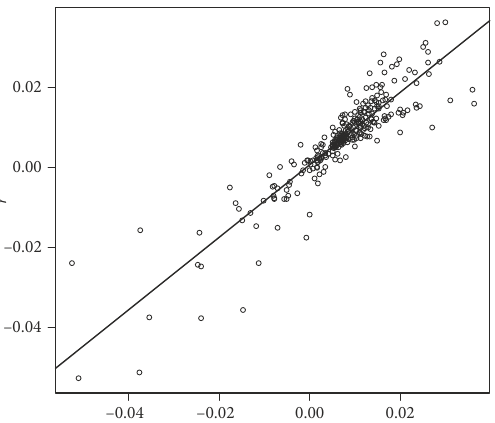
Figure 2. Regression of the total monthly returns of the IPD index (1987–2010) and its preceding period